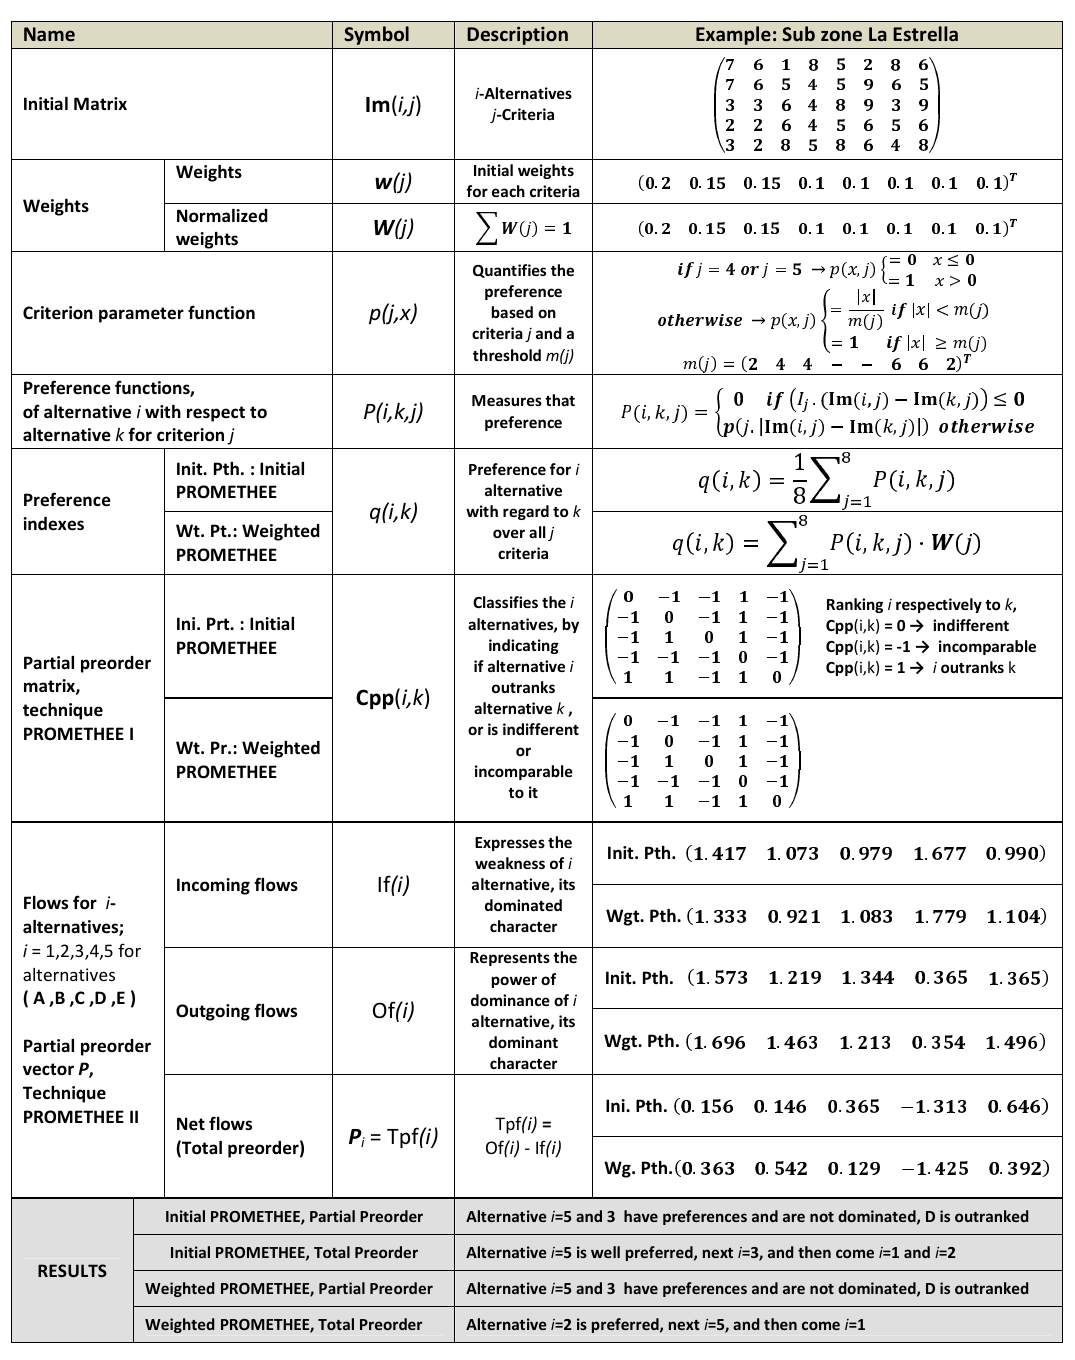
Fig. 6. Mathematical elements of erosion and desertification integral control plan using Partial and Total Preorder for Initial PROMETHEE, and for Weighted